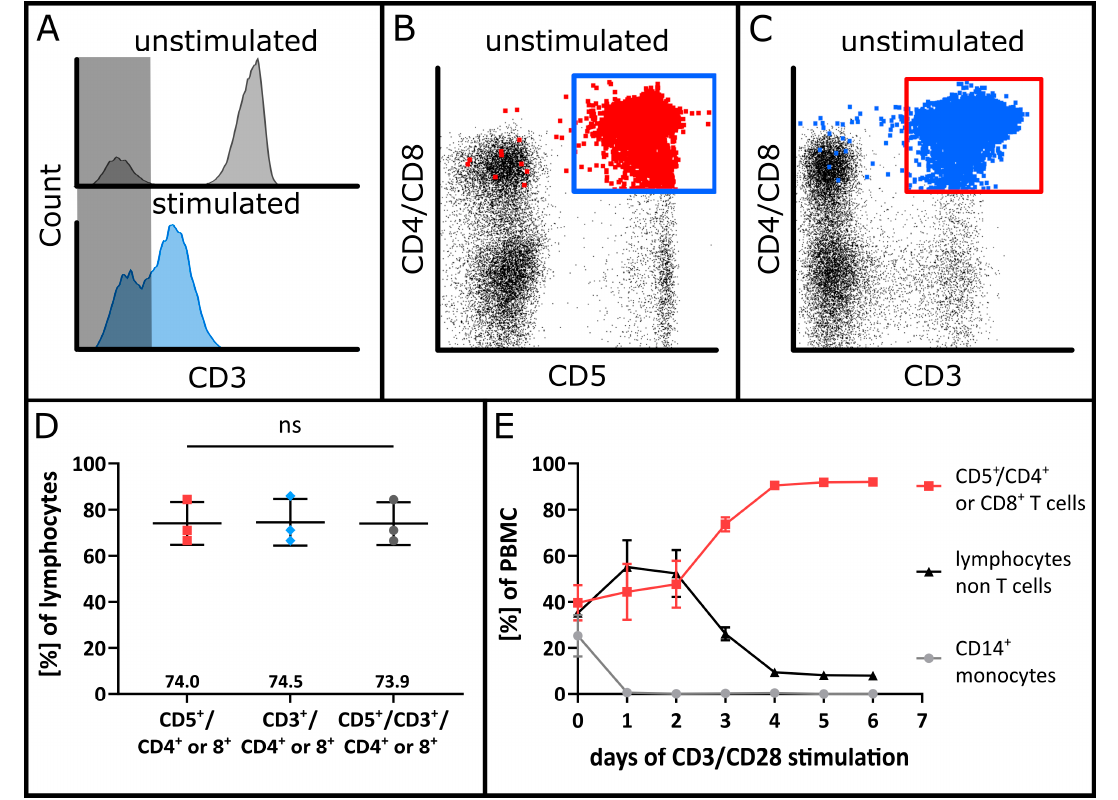
Figure 2. Specific analysis of T cells as target population. ( A ) Loss in the distinct separation of T cells using cell surface staining of the CD3 receptor after co-stimulation with anti-CD3 and anti-CD28 antibodies. The CD3 gate was set according to the unstimulated control visible in the upper histogram. The area containing CD3 negative cells is highlighted in grey. PBMCs after co-stimulation in the presence of MSCs are depicted in the lower histogram. The CD3 − and CD3 + populations are overlapping, which impedes the specific identification of T cells. ( B ) Representative dot plot of PBMCs prior to MLR co-cultures gated on CD3 + and CD4 + or CD8 + for T cell identification. T cells alternatively identified with CD5 + and CD4 + or CD8 + are displayed in red and emphasised. ( C ) Representative dot plot of CD5 + and CD4 + or CD8 + T cells prior to seeding for MLR co-cultures. CD3 + and CD4 + or CD8 + T cells are displayed in blue and emphasised. ( D ) Comparison of unstimulated T cell populations identified with CD5 or CD3 combined with CD4 + or CD8 + surface marker expression and co-expression. Mean values are indicated above the X -axis. Statistical analysis was performed using a repeated-measure one-way ANOVA with α = 0.05. ( E ) Specific enrichment of T cells after co-stimulation with anti-CD3 and anti-CD28 antibodies. Changes in PBMC subpopulations are shown on the day of seeding and additionally after one, two, three, four, five and six days of culture. T cells are defined as CD5 + and CD4 + or CD8 + cells.